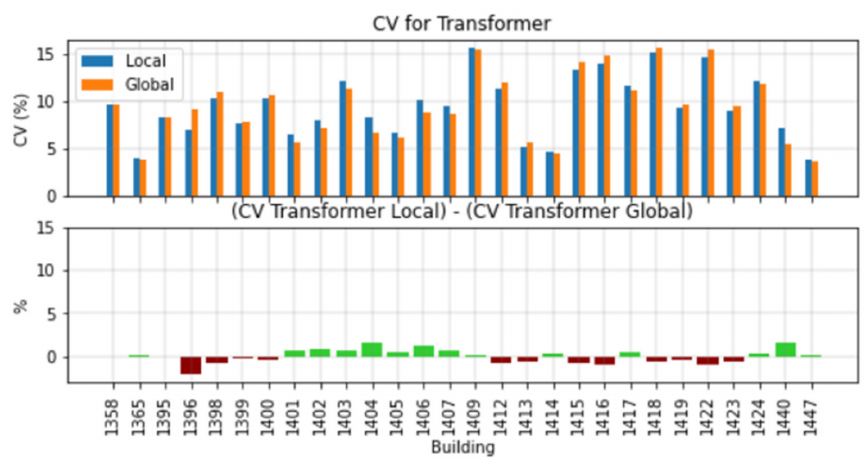
Figure 15. Comparison (in the upper figure) and difference (in the lower figure) between the CV obtained from local and global Transformer models on test set.